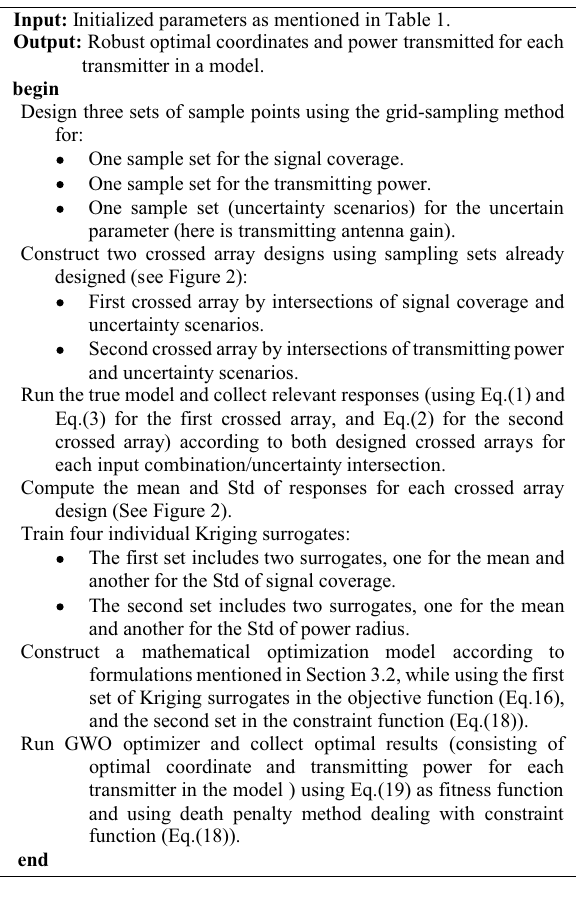
Algorithm 2 The proposed hybrid approach in